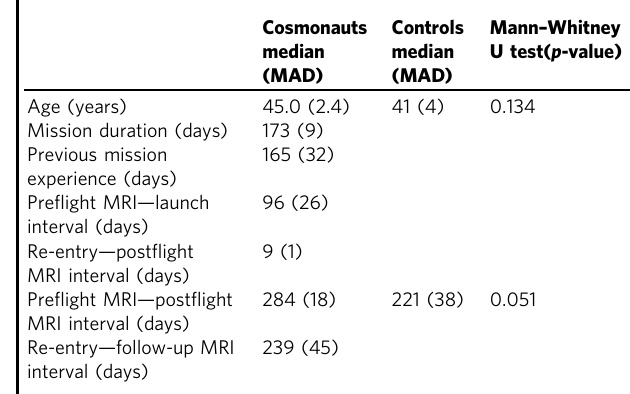
Table 3 Demographic information of the cosmonaut and control groups (all